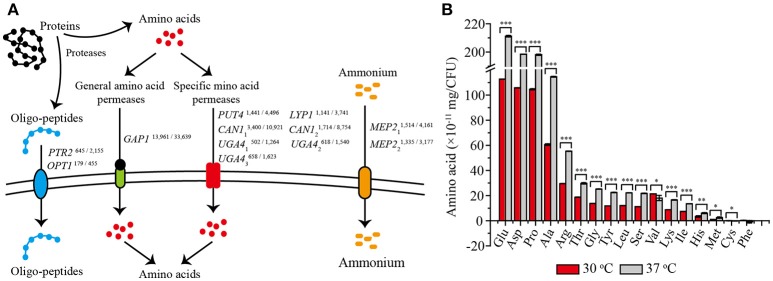
Differentially expressed genes related to amino acid transport (A) and the absorption of 17 conventional amino acids (B) at 30 and 37°C after 24 h of cultivation. The RPKM value of each gene is presented in the upper right corner, and the numbers on the left and right represent the RPKM values of Z. bailii MT15 at 30 and 37°C, respectively. Significance level of the one-way ANOVA: *0.05 > P > 0.01; **0.01 > P > 0.001; ***P < 0.001.